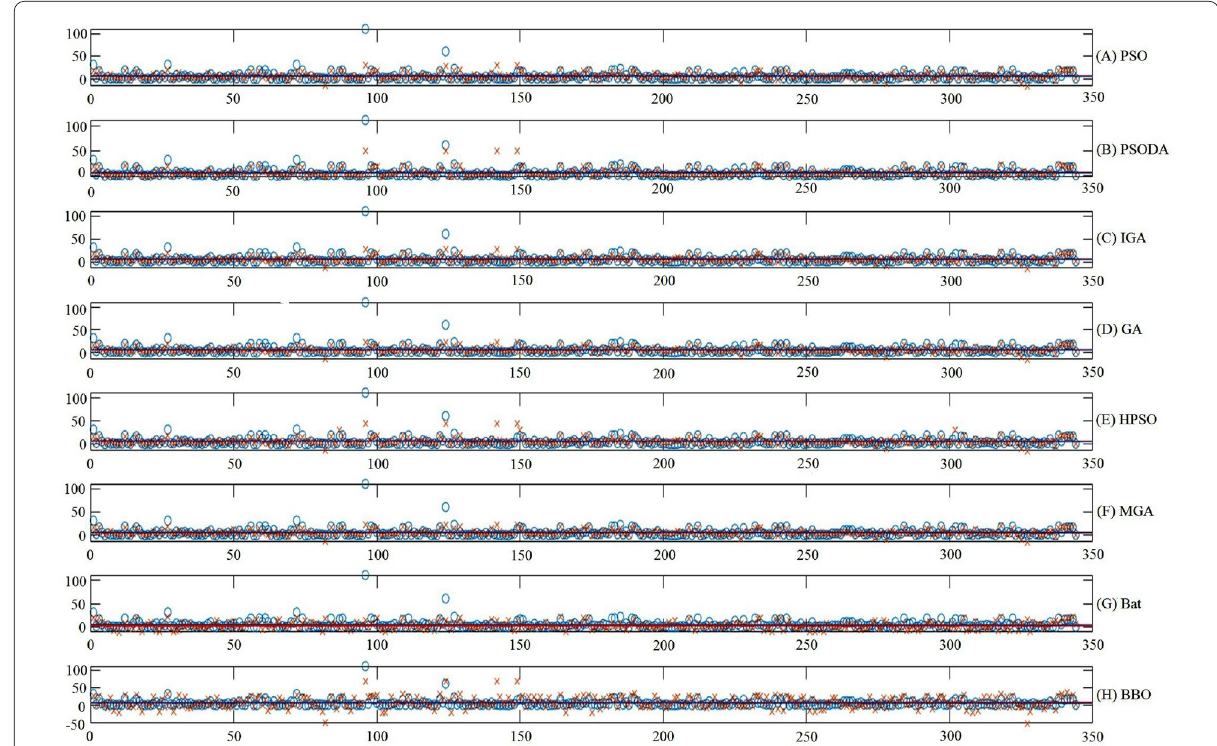
Fig. 16 Regression line plot for the train